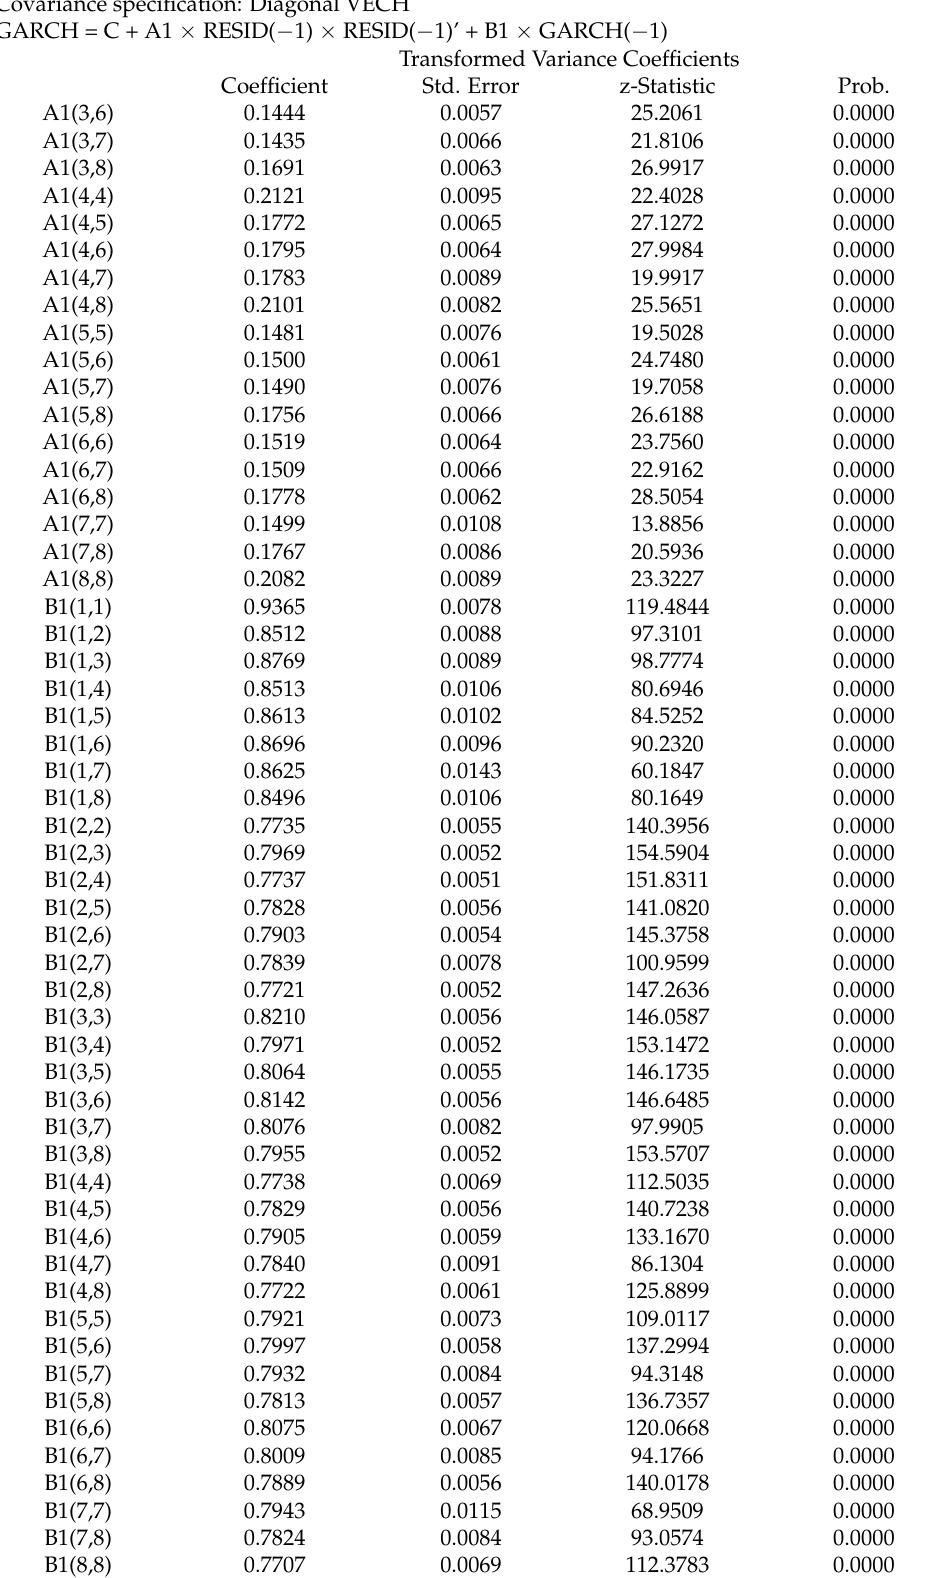
Table A2. Cont. Covariance specification: Diagonal